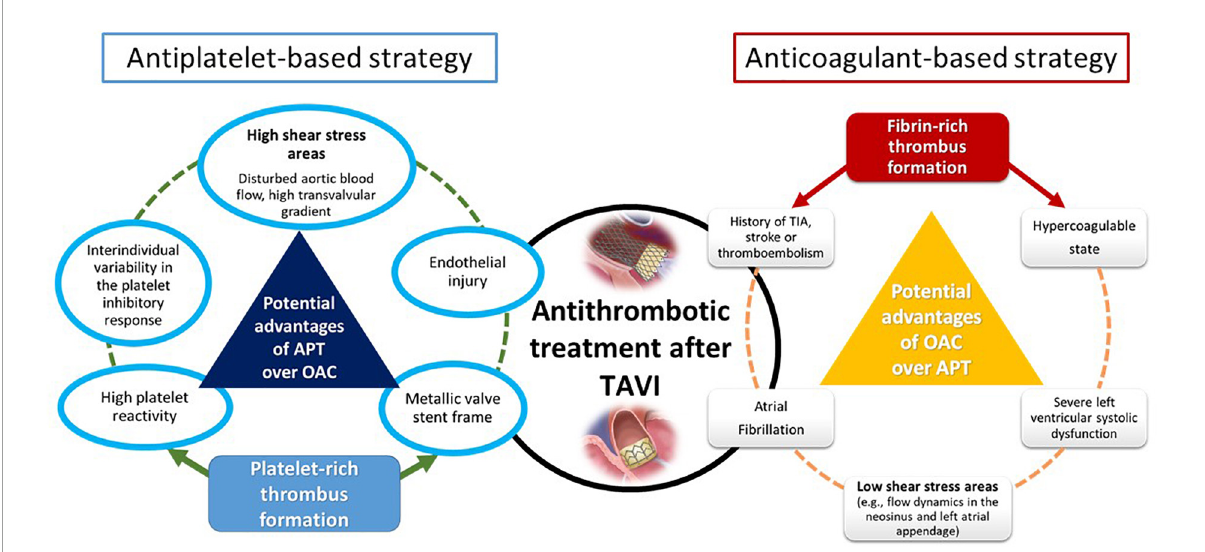
FIGURE1 Potential mechanisms related to stroke after TAVI and main antithrombotic strategies. TAVI, transcatheter aortic valve implantation; APT, antiplatelet therapy; OAC, oral anticoagulation therapy; TIA, transient ischemic attack.